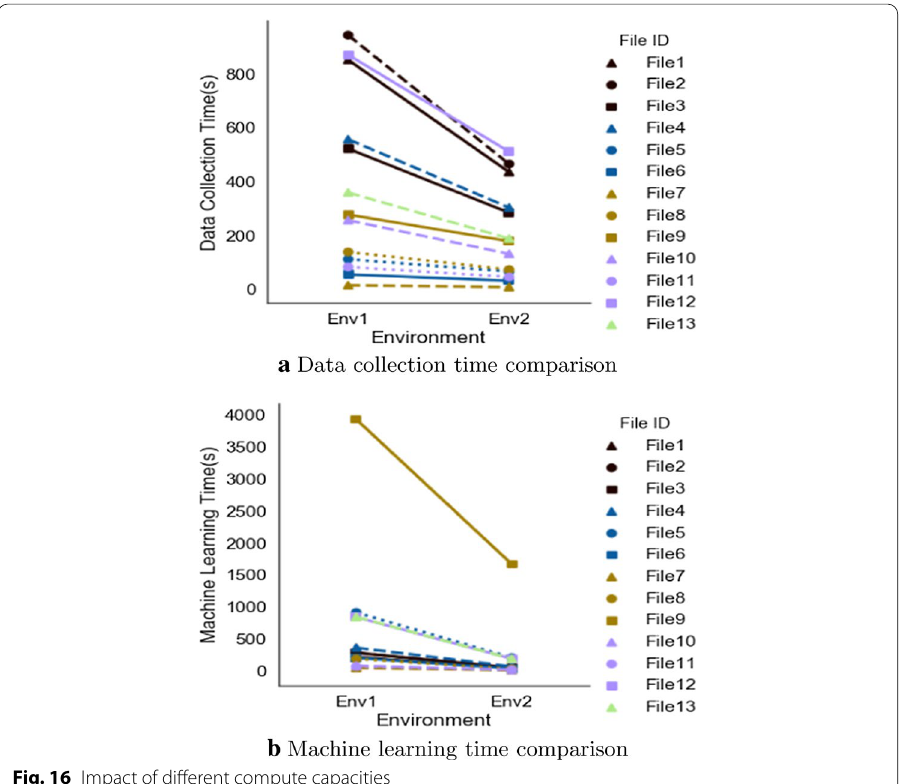
Fig. 16 Impact of different compute capacities